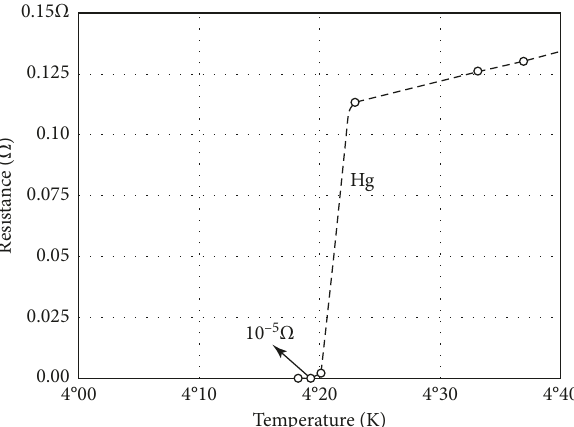
Figure 1: Resistance of a specimen of mercury versus absolute temperature